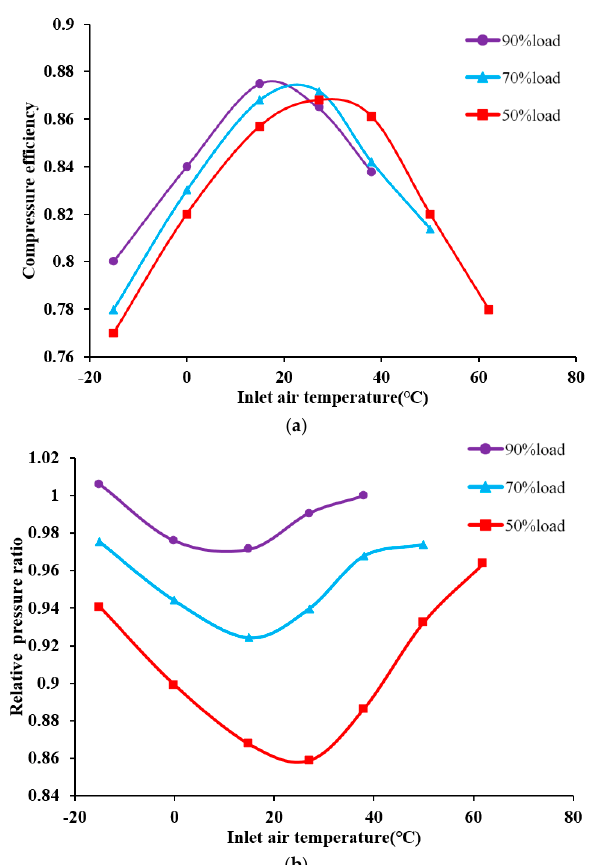
Figure 5. Compressor performance parameters at varying inlet air temperatures. ( a ) Compressor e ffi ciency; ( b ) Relative pressure